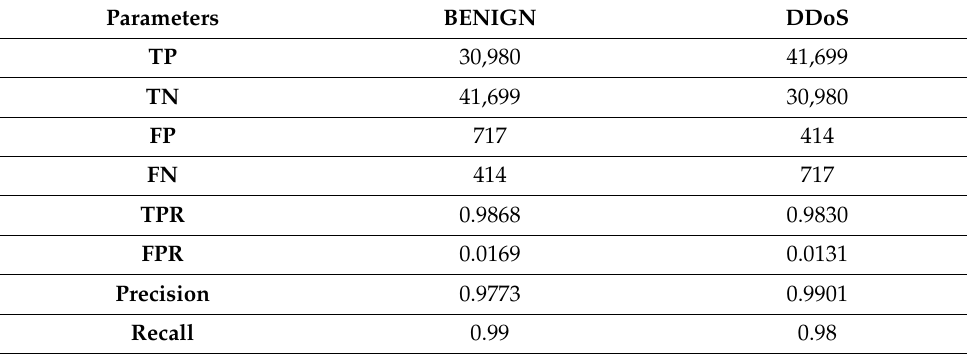
Table 9. Statistical report of Friday afternoon-DDoS test dataset.